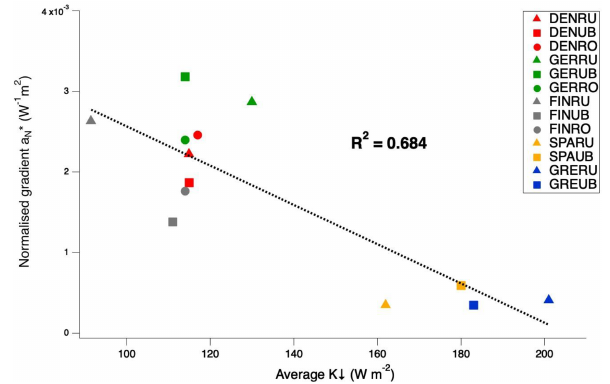
Figure 2. Relation of average downward incoming solar radiation ( K ↓ ) and normalised gradients a ∗ N